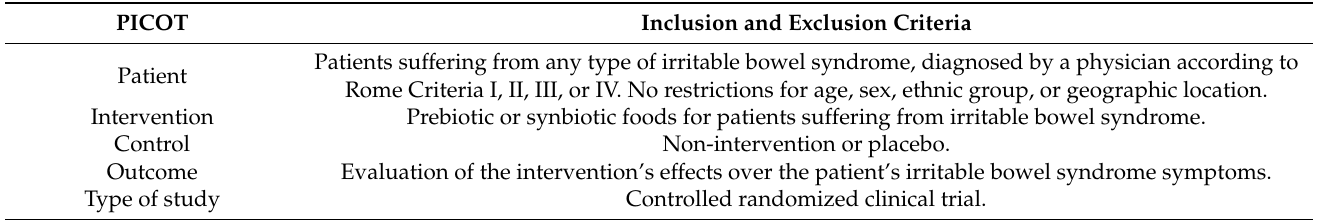
Table 1. PICOT* criteria used to determine the search’s question and strategy. PICOT Inclusion and Exclusion Criteria Patients suffering from any type of irritable bowel syndrome, diagnosed by a physician according to Patient Rome Criteria I, II, III, or IV. No restrictions for age, sex, ethnic group, or geographic location. Intervention Prebiotic or synbiotic foods for patients suffering from irritable bowel syndrome. Control Non-intervention or placebo. Outcome Evaluation of the intervention’s effects over the patient’s irritable bowel syndrome symptoms. Type of study Controlled randomized clinical